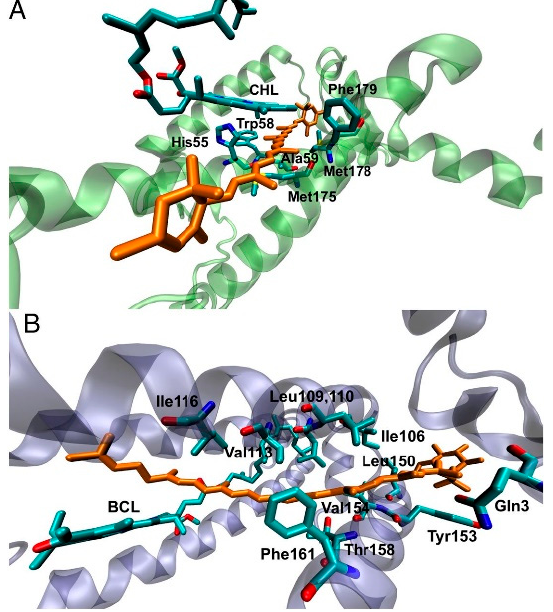
Figure 9. ( A ) Structural model of lutein 2 (orange) in LHCII monomer. ( B ) Structural model of rhodopin glucoside (orange) in LH2. The proximal (bacterio) chlorophyll, and amino acid residues that are within 3.5 Å of lutein are shown. These residues make up the QM layer in the QM/MM simulations. Reproduced from [114] with permission from National Academy of Sciences, 2017.